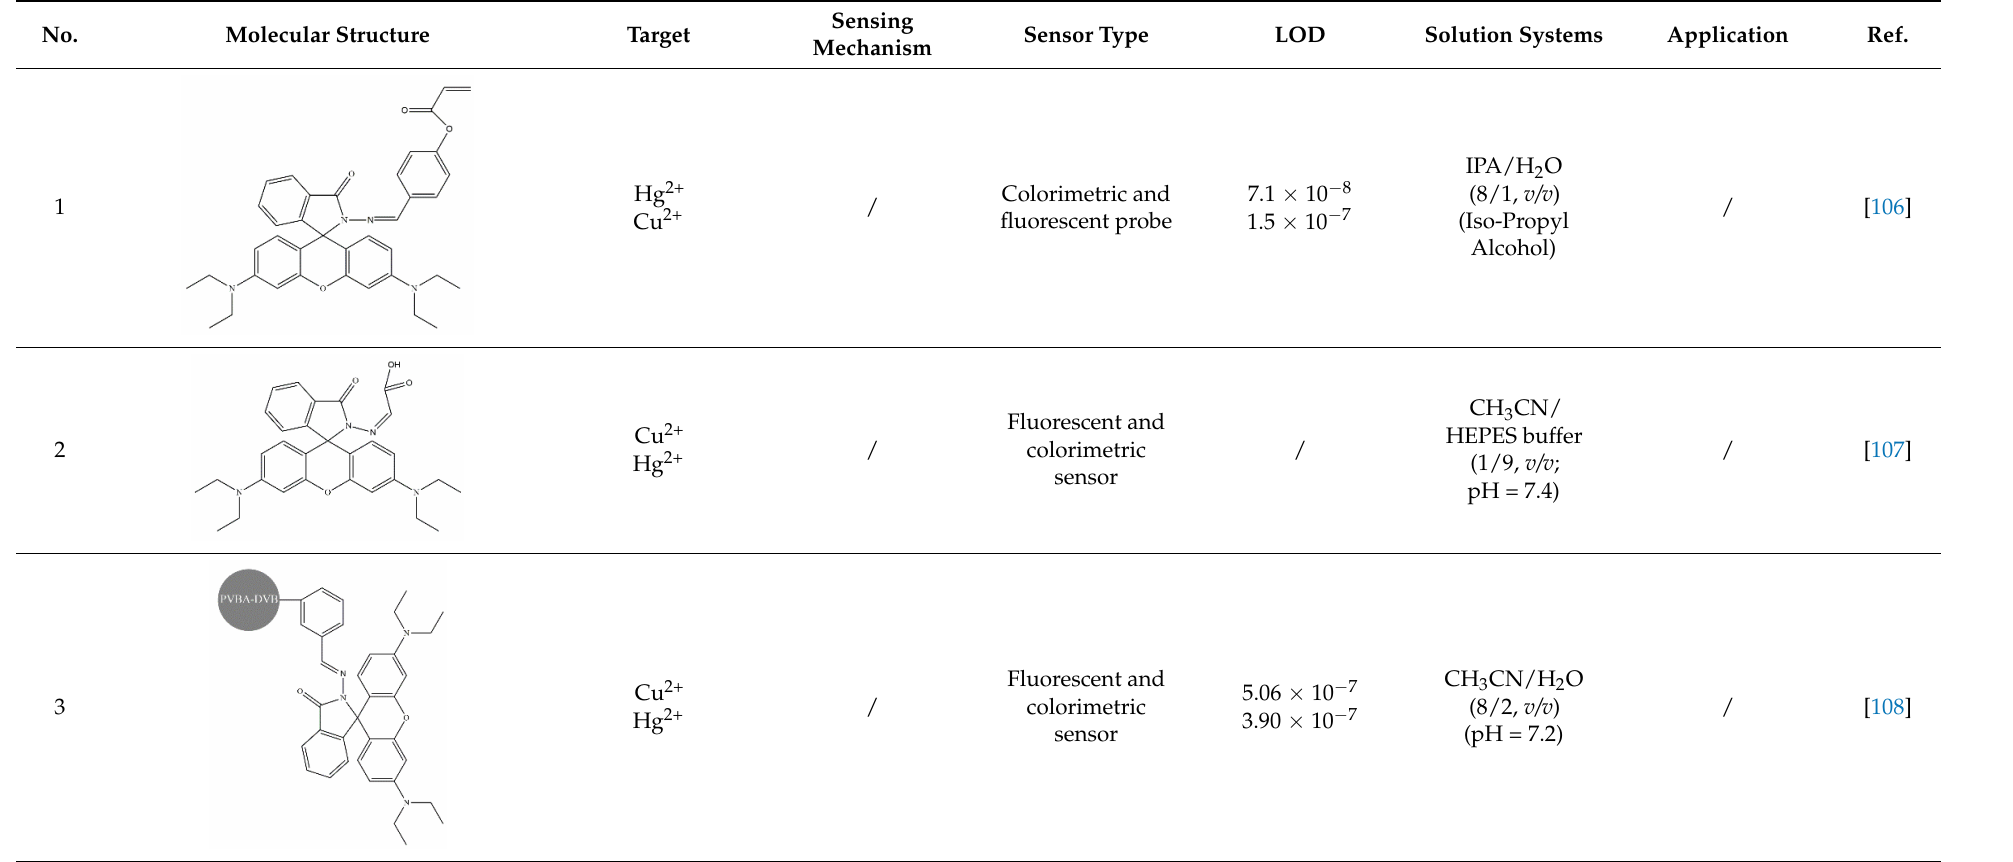
Table 4. Rhodamine-based sensors for